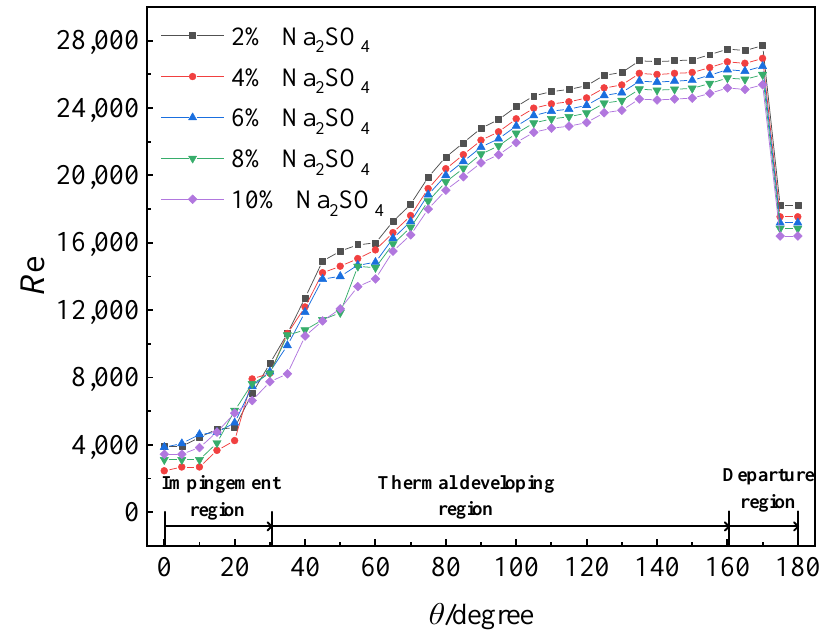
Figure 3. Local Reynolds number around tube under various Na 2 SO 4 content.